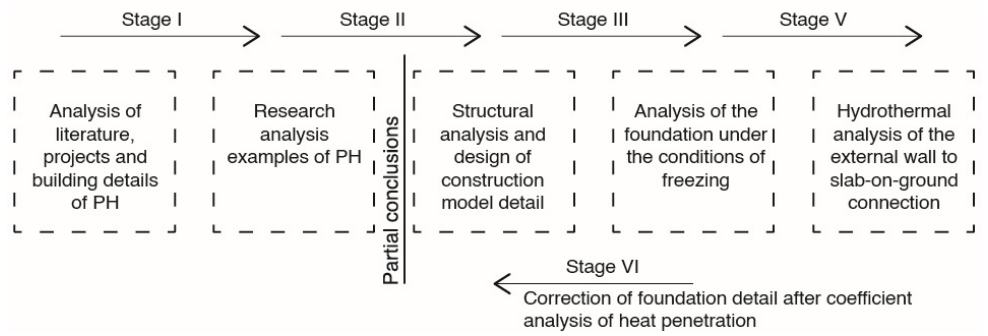
Figure 1. Scheme of the methodology.